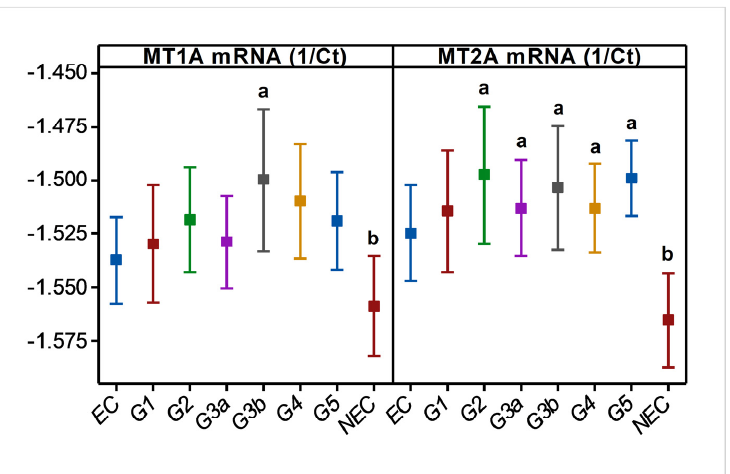
Figure 1. Variation in blood MT1A and MT2A mRNA levels during CRF progression in CKDu endemic area. MT; metallothionein, Ct; cycle threshold (RTPCR), EC; endemic control, and G1-G5; CKD stage groups, NEC; nonendemic control. n = 110. Log10 MT data are shown as mean and 95% confidence interval in linear scale Y axes. a and b indicate significance at p < 0.01 between two means (one-way ANOVA, Tukey HSD).